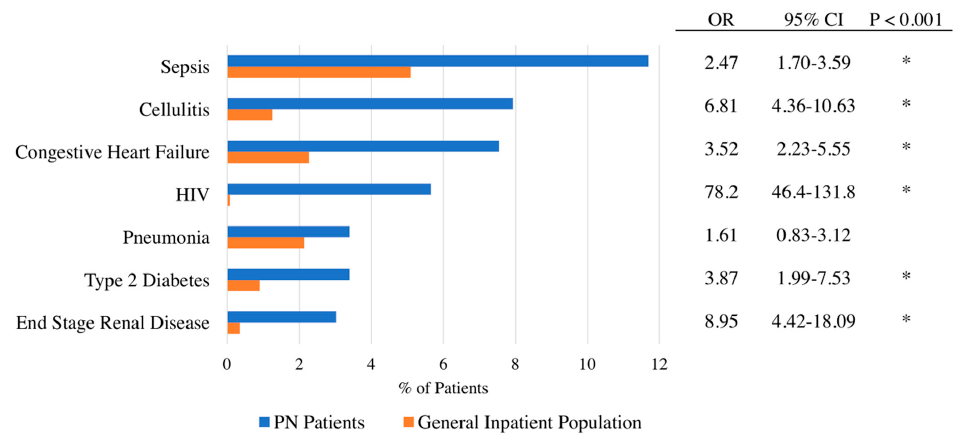
Figure 2. Comparison of primary admission reason. Primary admission reason for prurigo nodularis patients compared to patients with no prurigo nodularis.